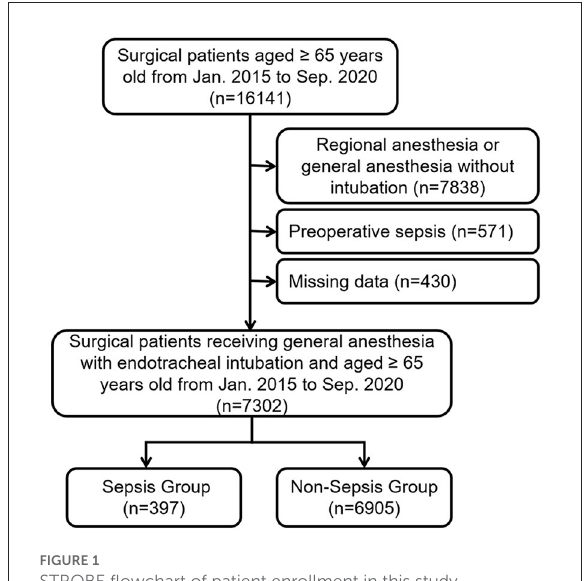
FIGURE1 STROBE flowchart of patient enrollment in this study.